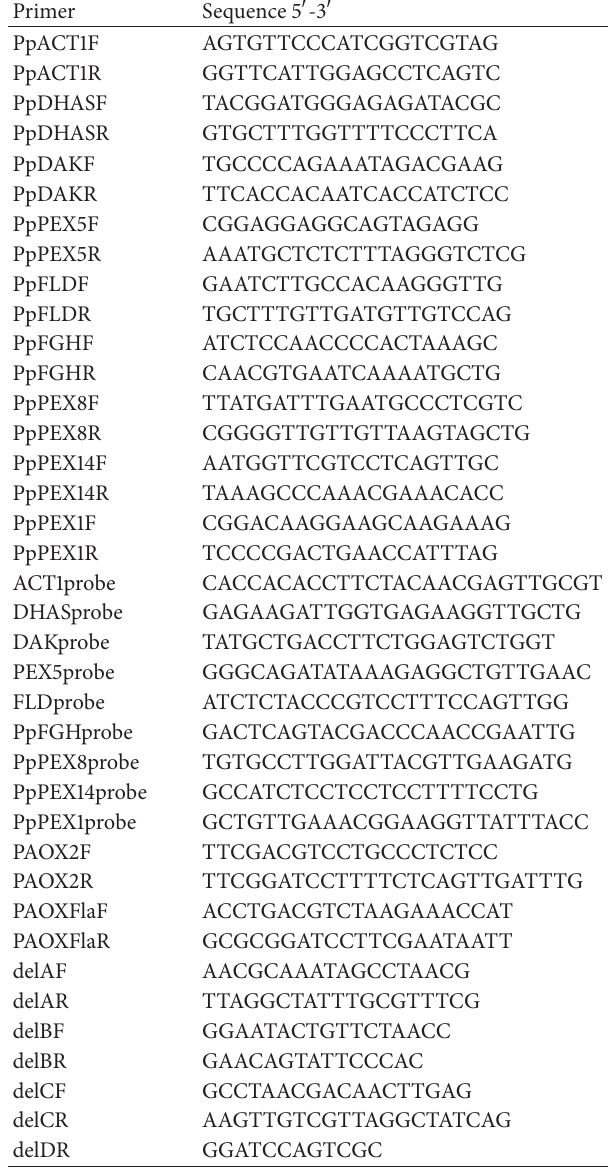
Table 1: P. pastoris strains used in this study. Strain